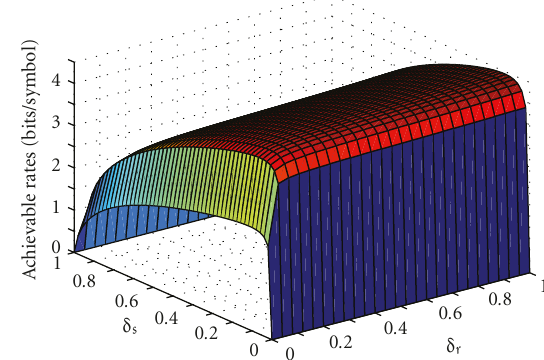
Figure 5: Overlapped AF achievable rates versus δ s and δ r when P s = P r = 50